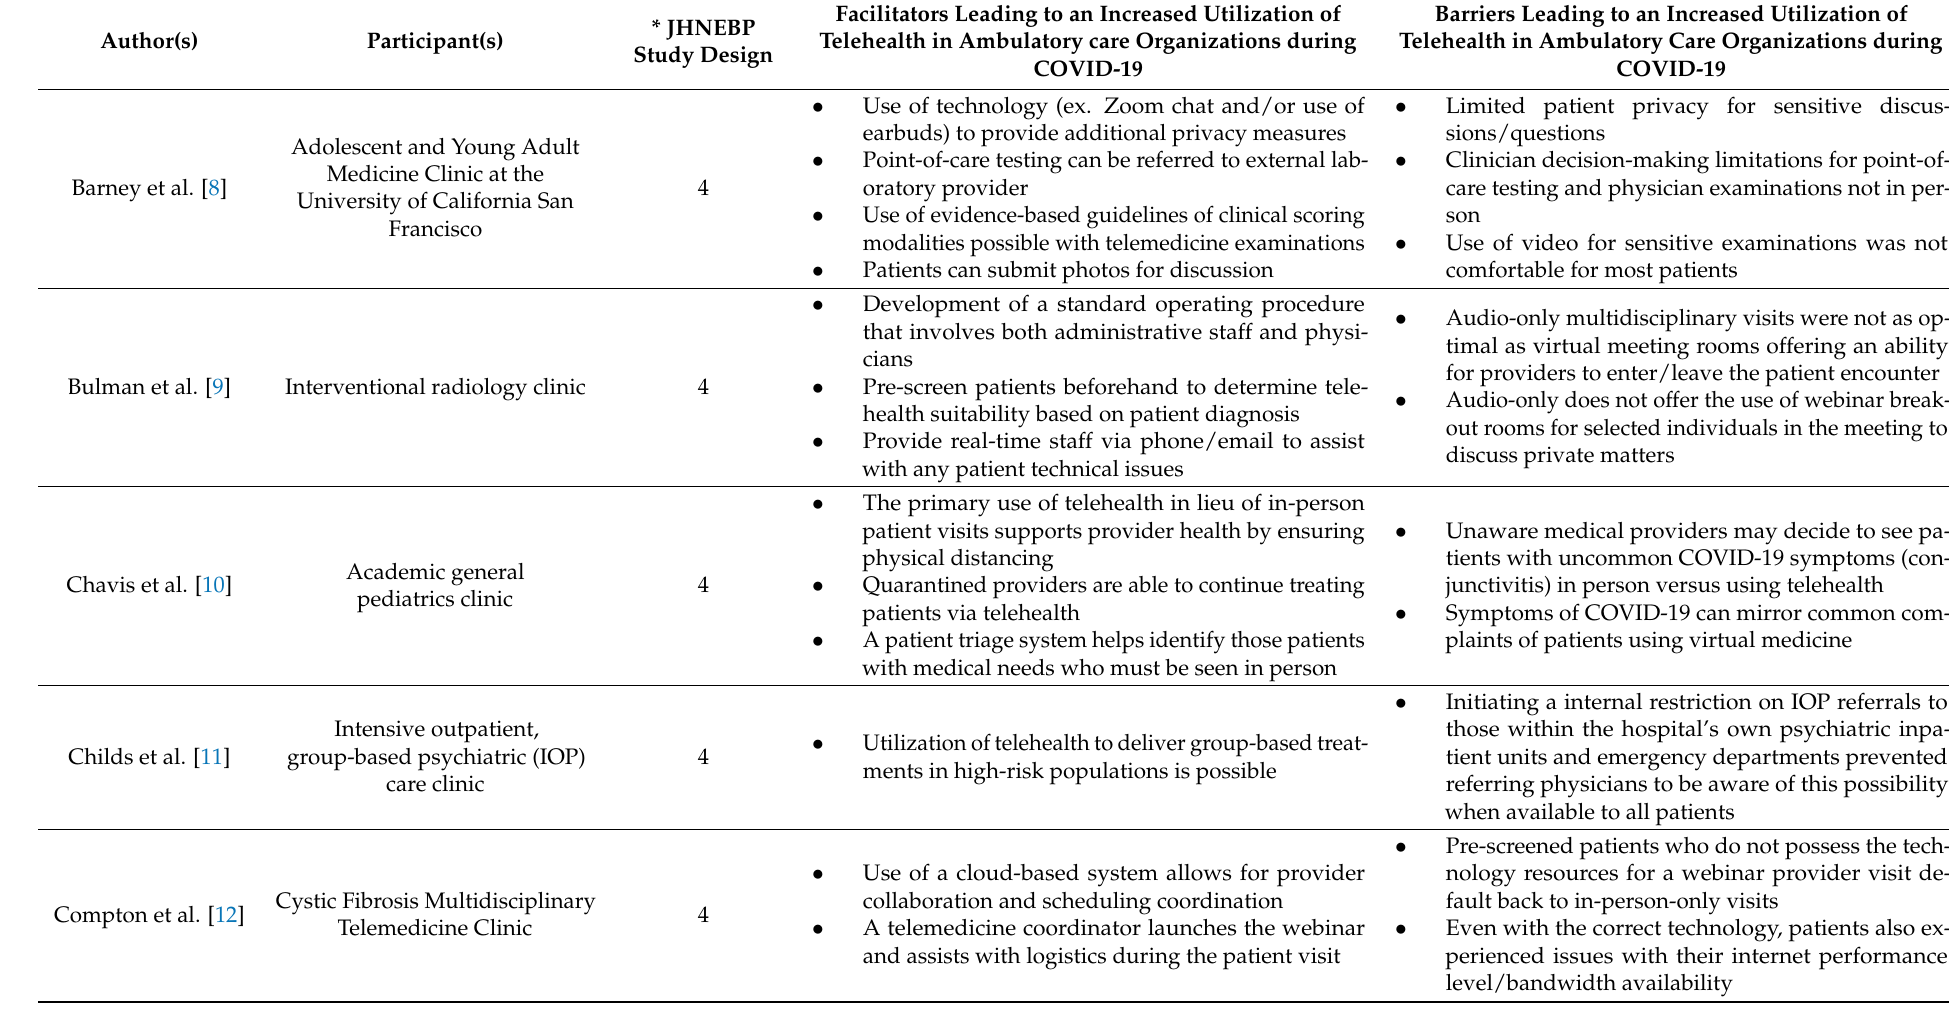
Table 1. Summary of findings ( n =